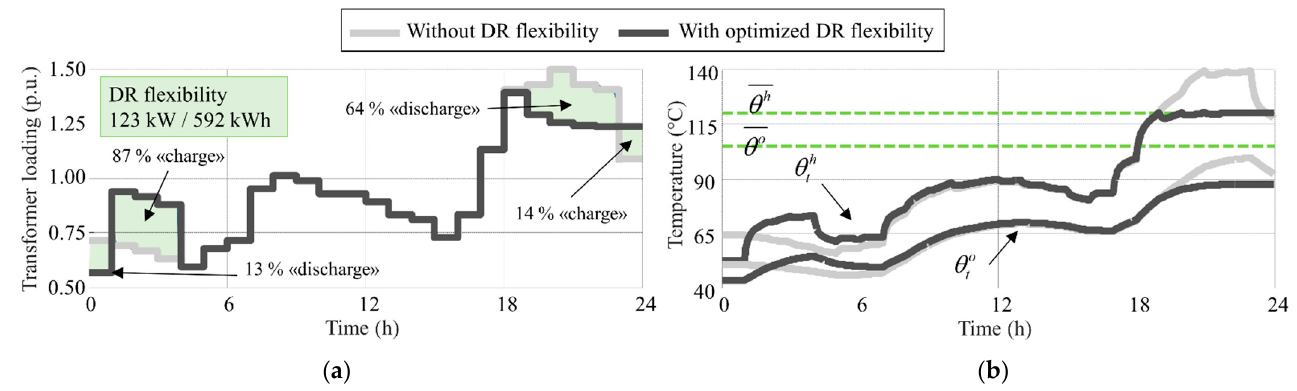
Figure 10. Validation run with “energy shifting”: ( a ) transformer loadings; ( b ) temperatures.